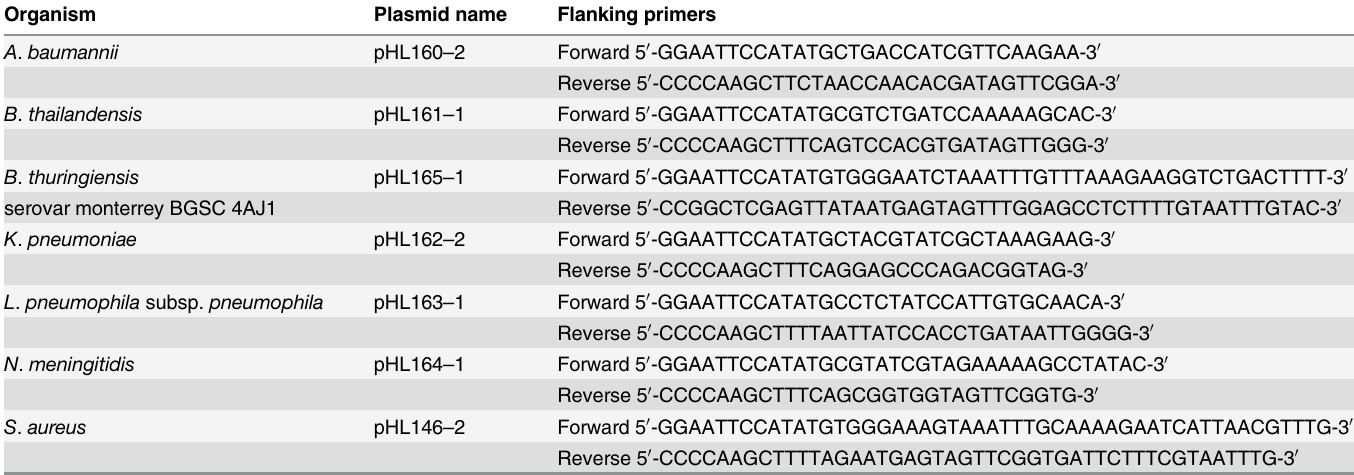
Table 1. Primers used for cloning the guaB gene from various bacteria and names of the corresponding plasmids. Organism